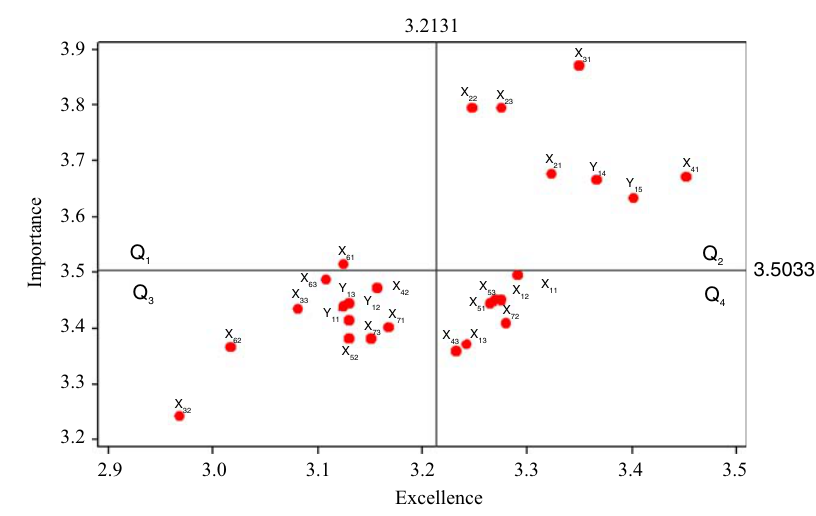
Figure 3. Results of hypothesis and the loading factors